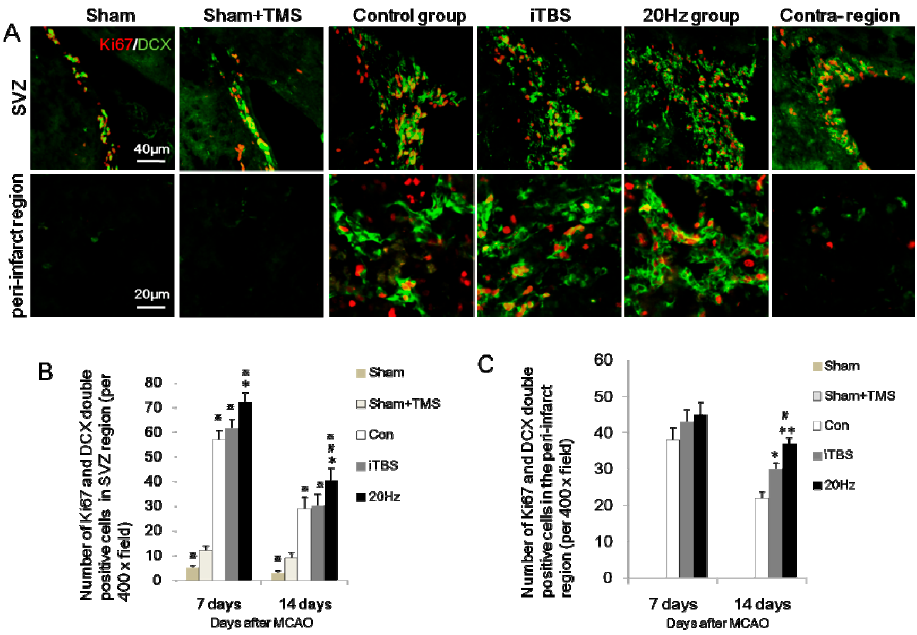
Figure 2. Expression of Ki67/doublecortin (DCX)-positive cells in the ipsilateral subventricular zone (SVZ) and peri-infarct striatum at 14 days after MCAO ( A ) Ki67 colocalized with DCX in cells of the ipsilateral SVZ zone and peri-infarct striatum. After 20 Hz rTMS, numerous cells within the SVZ zone and peri-infarct striatum displayed double-immunopositive signals for Ki67 and DCX, compared with the control group, iTBS group, sham + TMS group, and sham group. Sham and sham + TMS group showed no Ki67/DCX expression in the peri-infarct striatum. The contralateral SVZ showed less Ki67/DCX than the ipsilateral region; ( B , C ) Quantification of Ki67/DCX-positive cells in each group. Values are mean ± SD; * p < 0.05, ** p < 0.001 versus control group; and # p < 0.05 versus iTBS group; ※ p < 0.05 versus sham + TMS group.